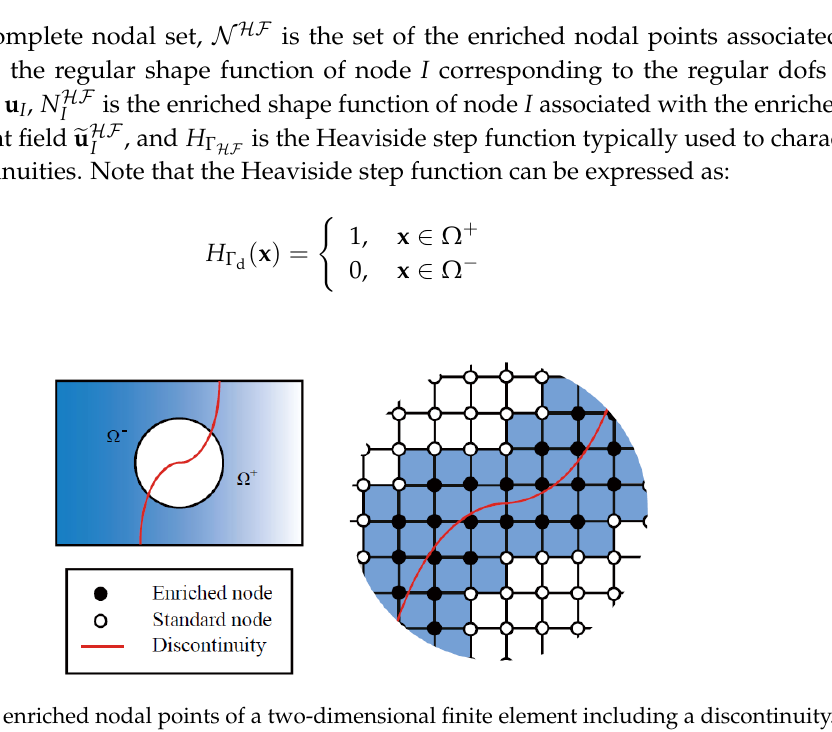
Figure 3. The enriched nodal points of a two-dimensional finite element including a discontinuity.